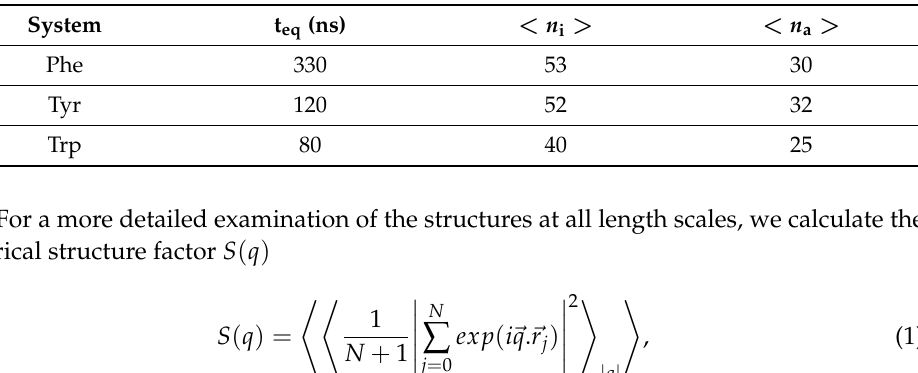
Table 1. The approximate equilibration times of the simulations in ns (t eq ), the average number of close contacts between the two ionized atoms ( < n i > ) and the average number of close contacts between the C α atoms of the different amino acid systems ( < n a > ).